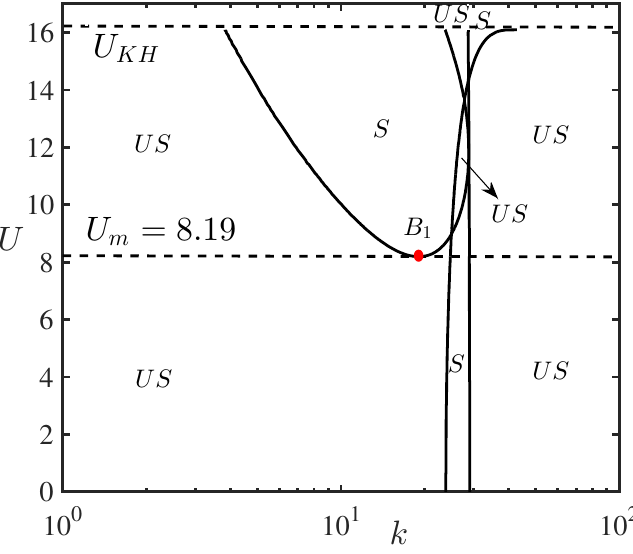
Figure 10. Zones of modulation stability ( S ) and instability ( US ) in the ( k , U ) plane. The dashed line on the top depicts the critical velocity U KH = 16.101/m at which the Kelvin–Helmholtz instability arises. The bifurcation point in the diagram is denoted by B 1 for U = U m